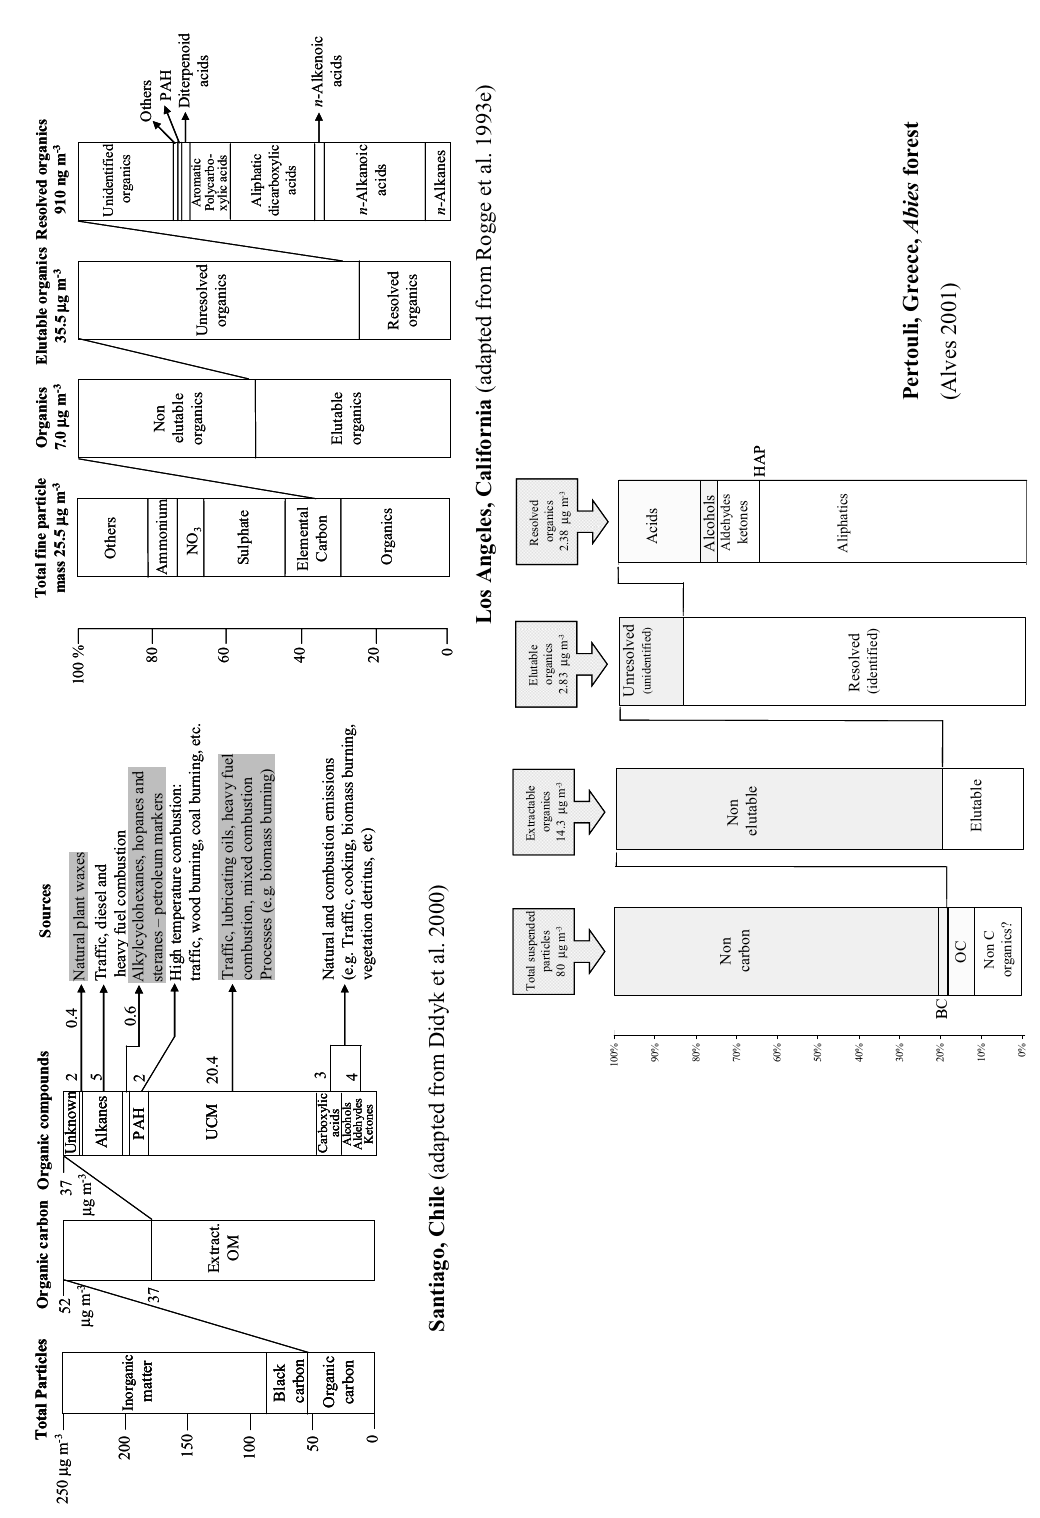
Fig. 5 – Material balances with the chemical composition of aerosols from different atmospheric environments.